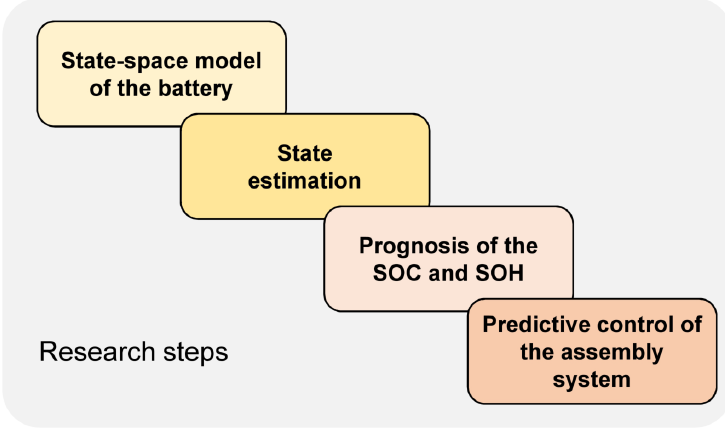
Figure 1. Research